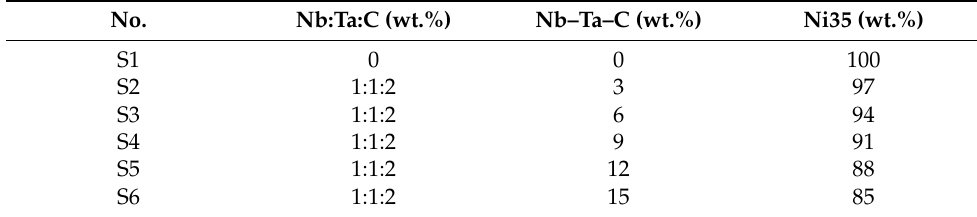
Table 1. Processing parameters of composite coating with different ceramic